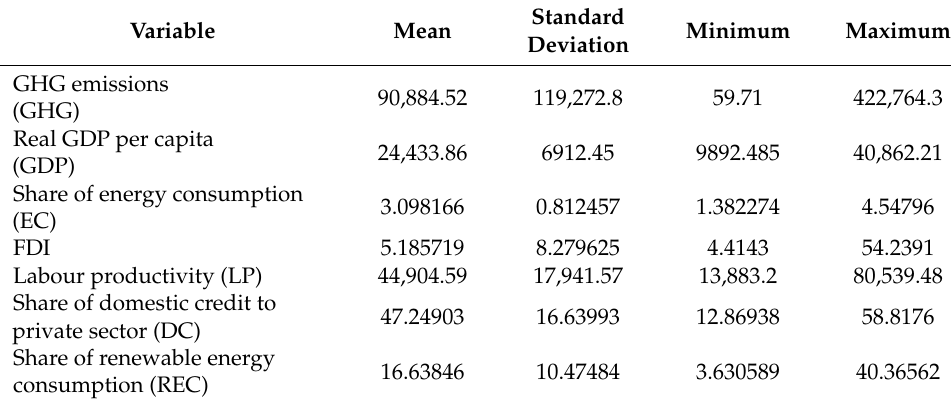
Table 1. Descriptive statistics 1